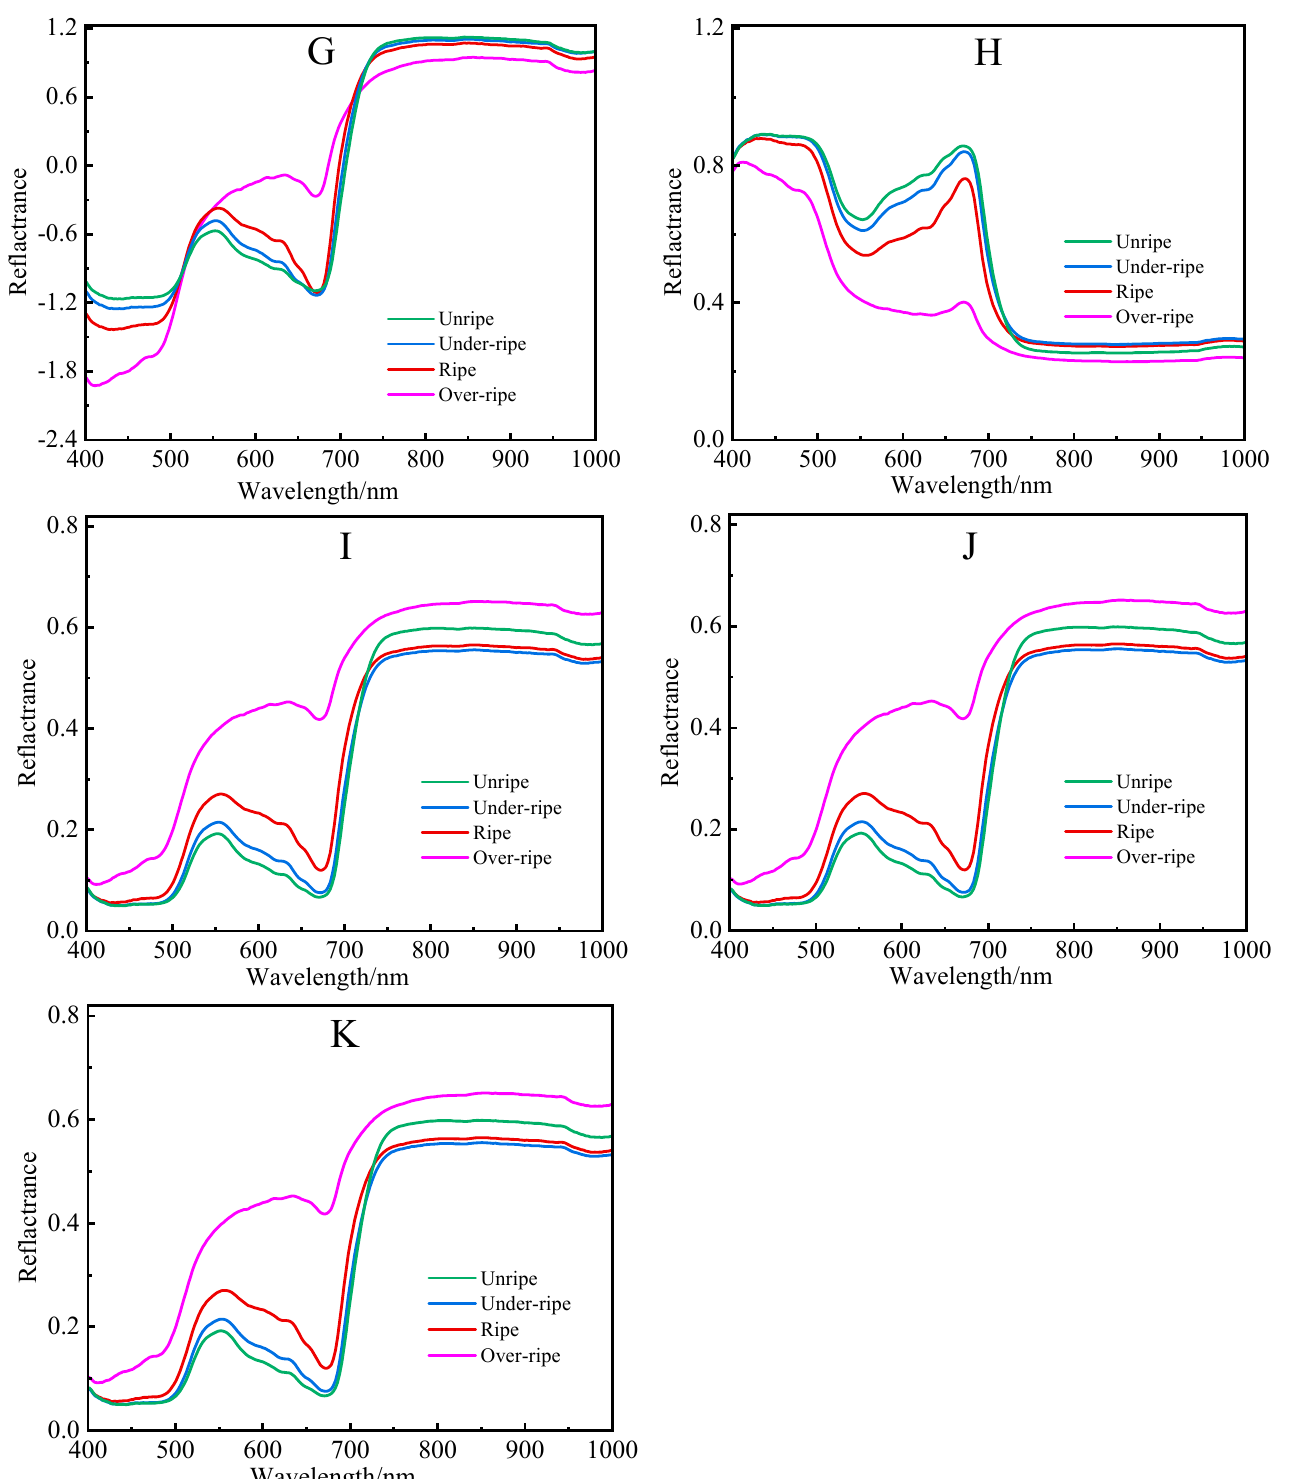
Figure 4. Spectra obtained with di ff erent fi ltering methods. ( A ) Baseline, ( B ) de-trending, ( C ) MSC, ( D ) normalize, ( E ) OSC, ( F ) SG, ( G ) SNV, ( H ) ST, ( I ) GF, ( J ) MA, and ( K ) MF.